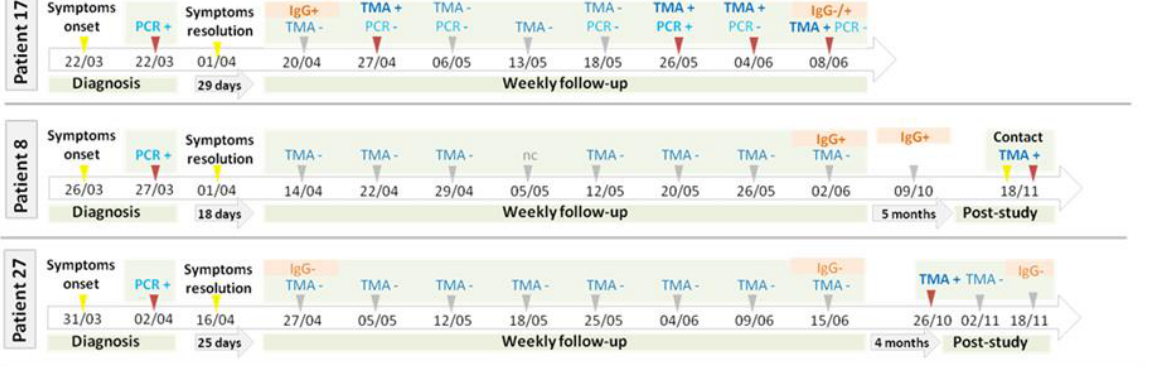
Figure 2. Timeline of participants with late newly acquired infection. TMA: transcription-mediated amplification, PCR: polymerase chain reaction.